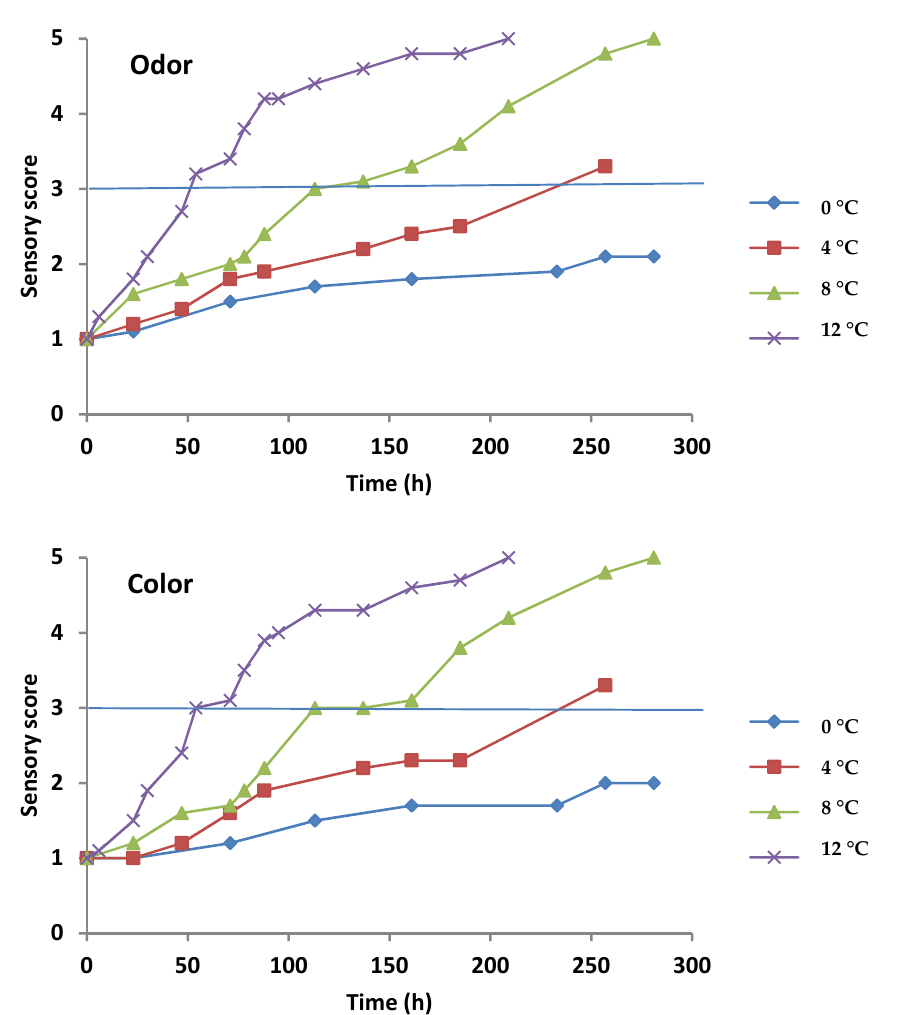
Figure 2 . Sensory scores of gilthead sea bream fillets for odor and skin color attributes stored under aerobic conditions. Solid line indicates the threshold value for sample rejection.